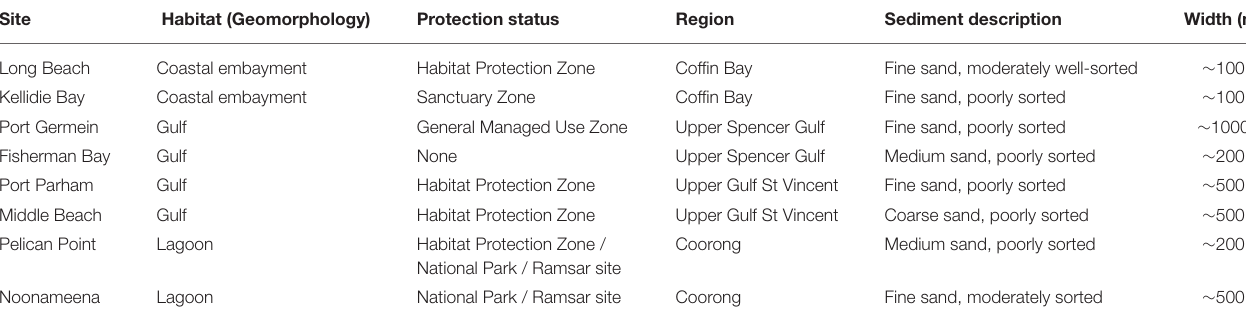
TABLE 1 | Main habitat characteristics of the eight sampling sites across southern